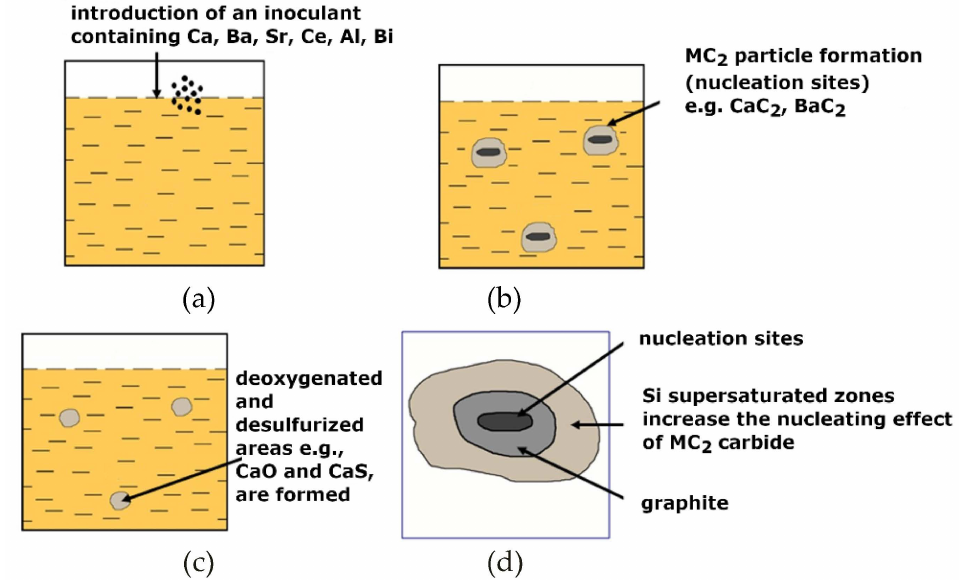
Figure 3. ( a ) Scheme of procedure for inoculation of grey cast iron: introduction of inoculant containing Ca, Ba, Sr, and Al; ( b ) formation of deoxidised and desulphurised areas (e.g., CaO and CaS); ( c ) formation of MC 2 (CaC 2 , BaC 2 ) particles (nucleation sites) on which graphite nucleates; ( d ) schematic of inoculant interaction in molten